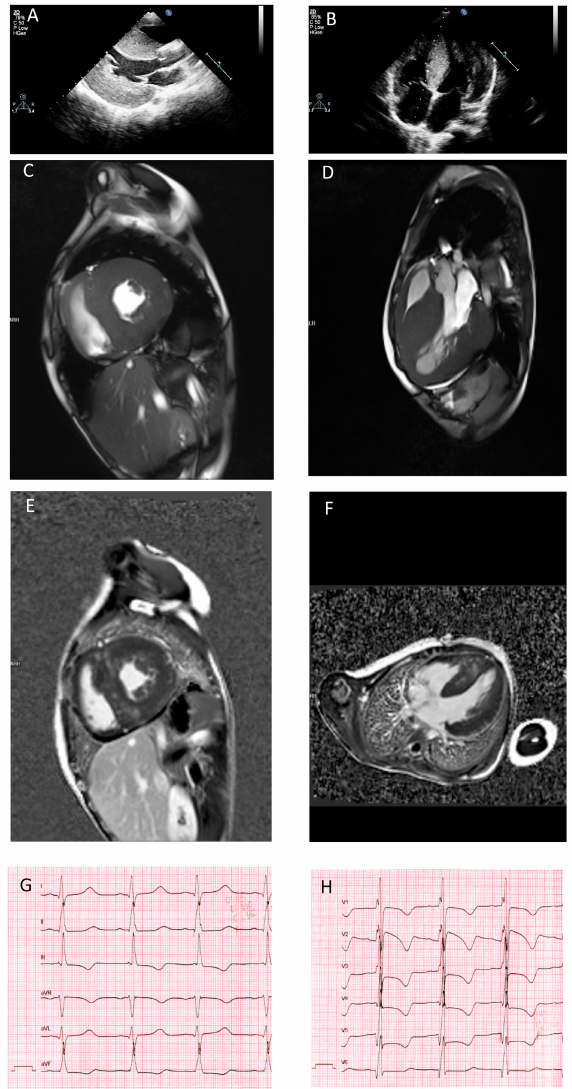
Figure 2. Morphological features of cardiomyopathy linked to ALPK3 variants. Echocardiography picture of Patient 1 corresponding to long-axis view ( A ) and four-chamber view ( B ) confirmed severe symmetrical wall hypertrophy and atrial enlargement. Cardiac MRI images of Patient 1 in the short ( C ) and long ( D ) axes, demonstrating wall hypertrophy, limited cavity volume and late gadolinium enhancement ( E , F ). Repolarization abnormalities of Patient 1 detected by ECG ( G , H